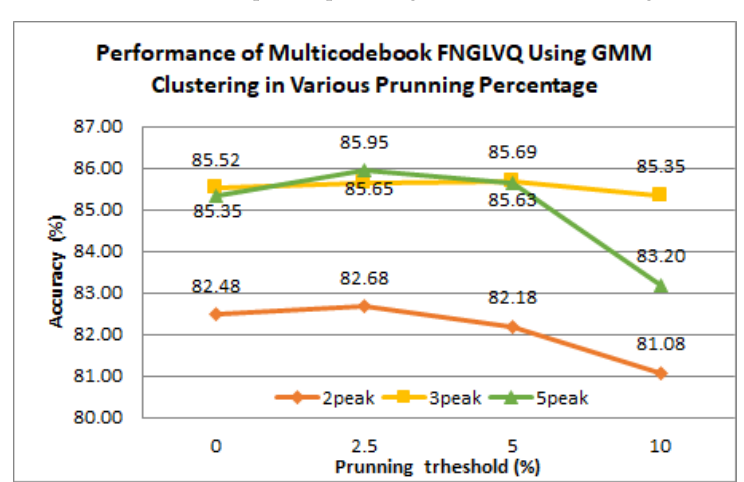
Figure 8. The impact of prunning on K-Means Clustering.